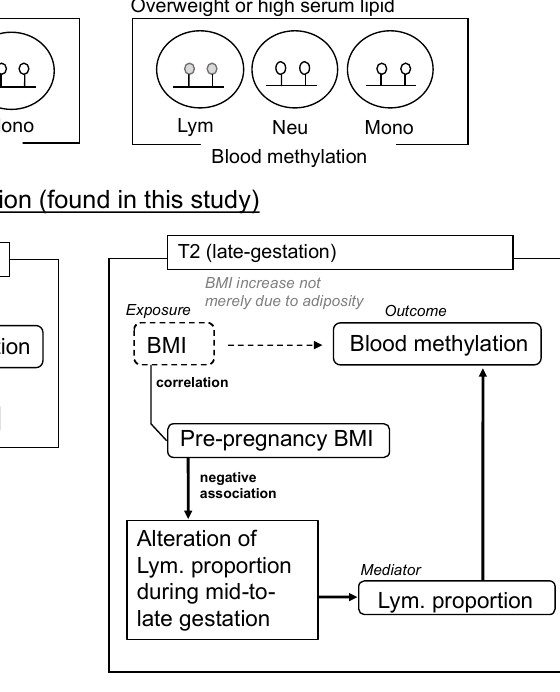
Figure 7. In late gestation, lymphocyte proportion mediates the effect of BMI on blood methylation of CPT1A intron 1. Lym, lymphocytes; Neu, neutrophils; Mono, monocytes.